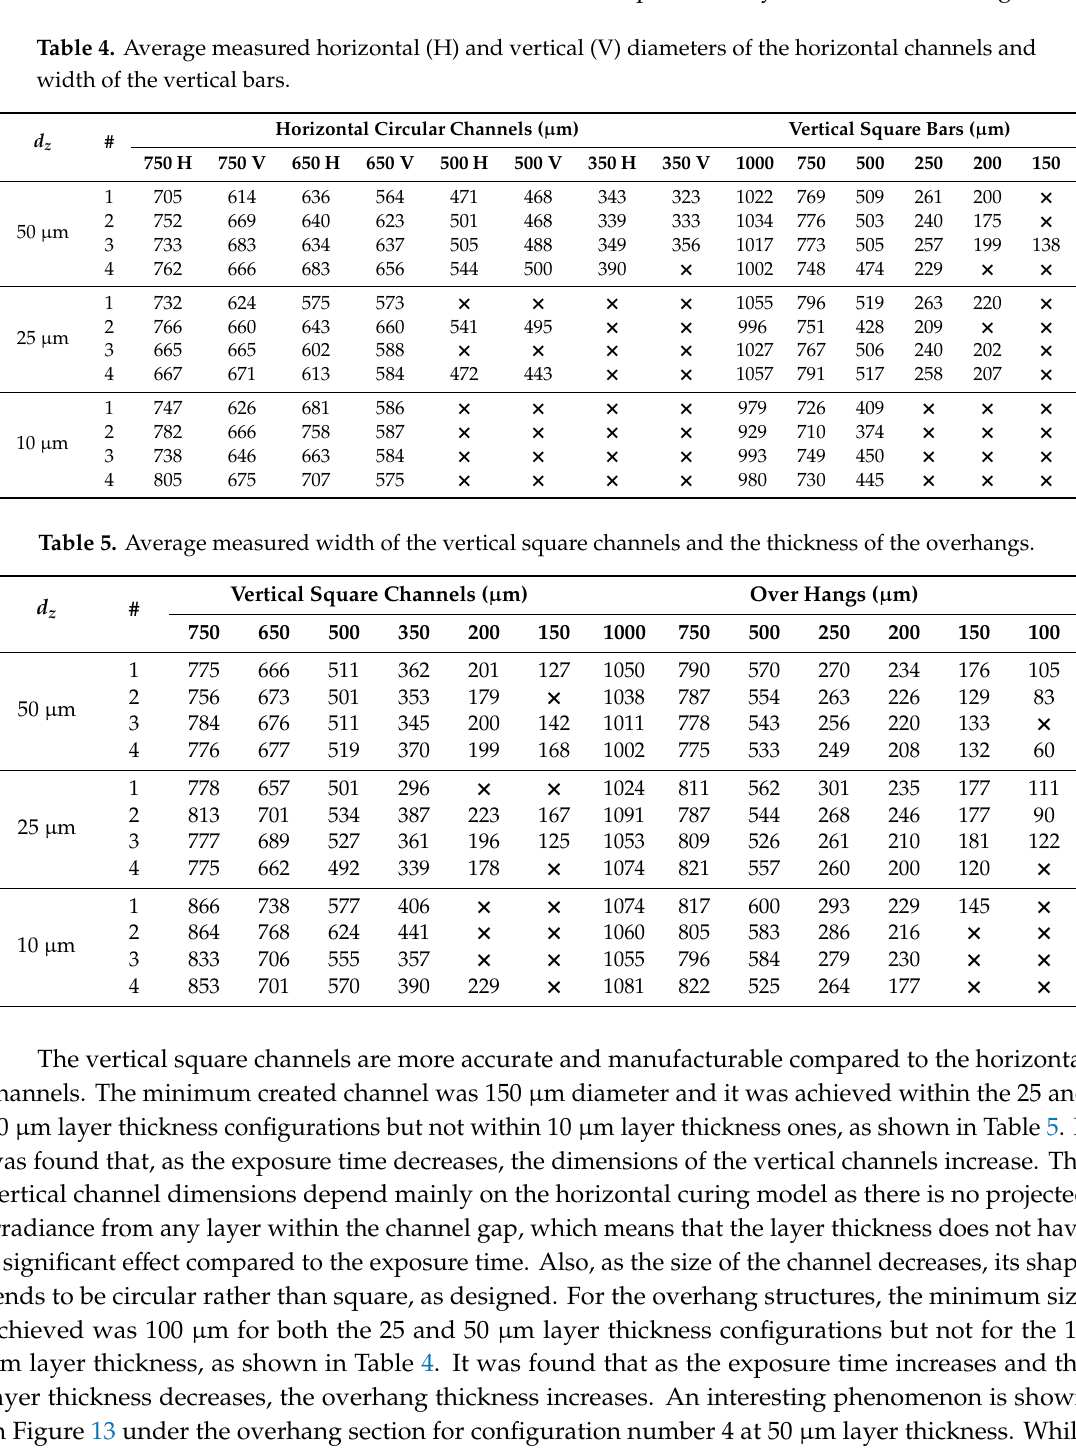
Table 4. Average measured horizontal (H) and vertical (V) diameters of the horizontal channels and width of the vertical bars.